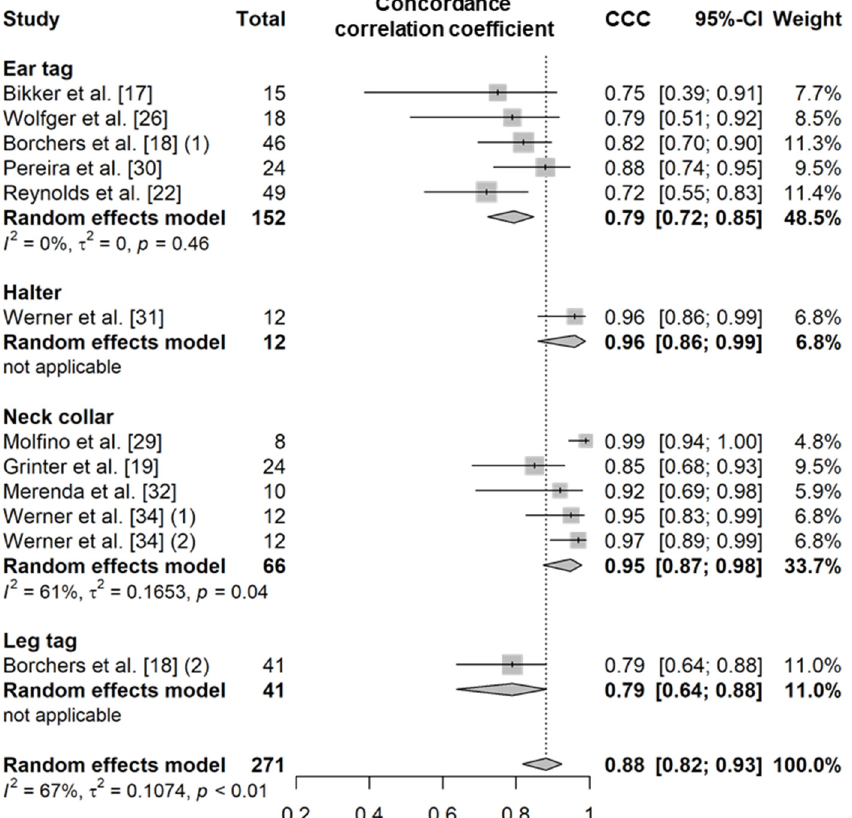
Figure 2. Forest plot of the concordance correlation coefficient of eating time between wearable sensors and visual observation. Numbers in parentheses indicate individual studies applying different evaluation conditions within the same article. ‘Total’ means the sample size of each study and ‘Weight’ means the weight for the mean based on the sample size.